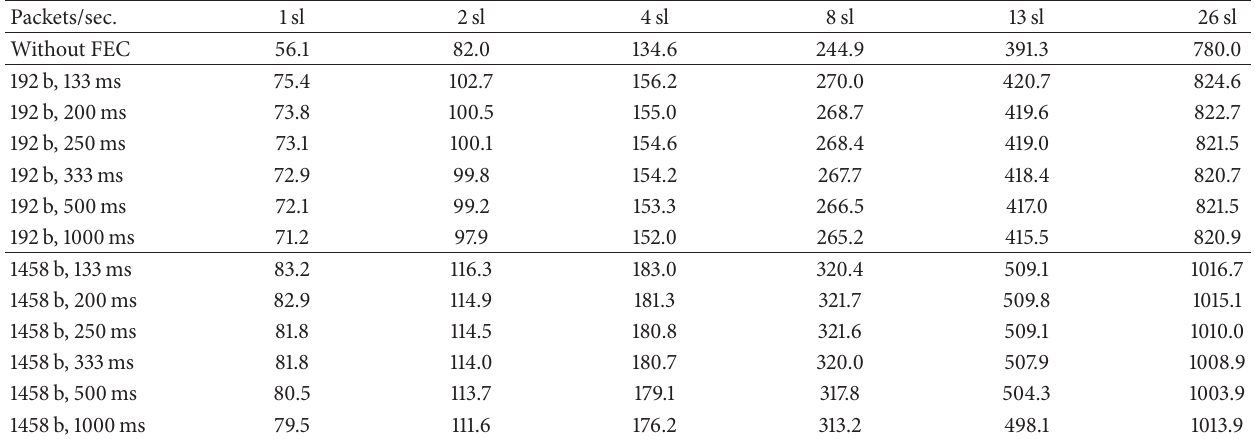
Table 2: Packet rate (packets per second) for LP mode without FEC protection and with FEC protection at 30% of redundancy for different symbol sizes, different protection windows, and different number of slices per frame.